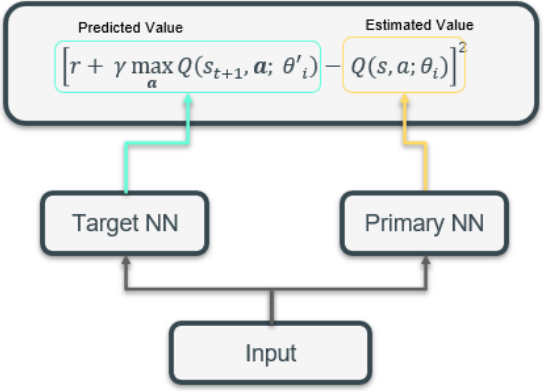
Figure 8. Estimation of Q value and Target